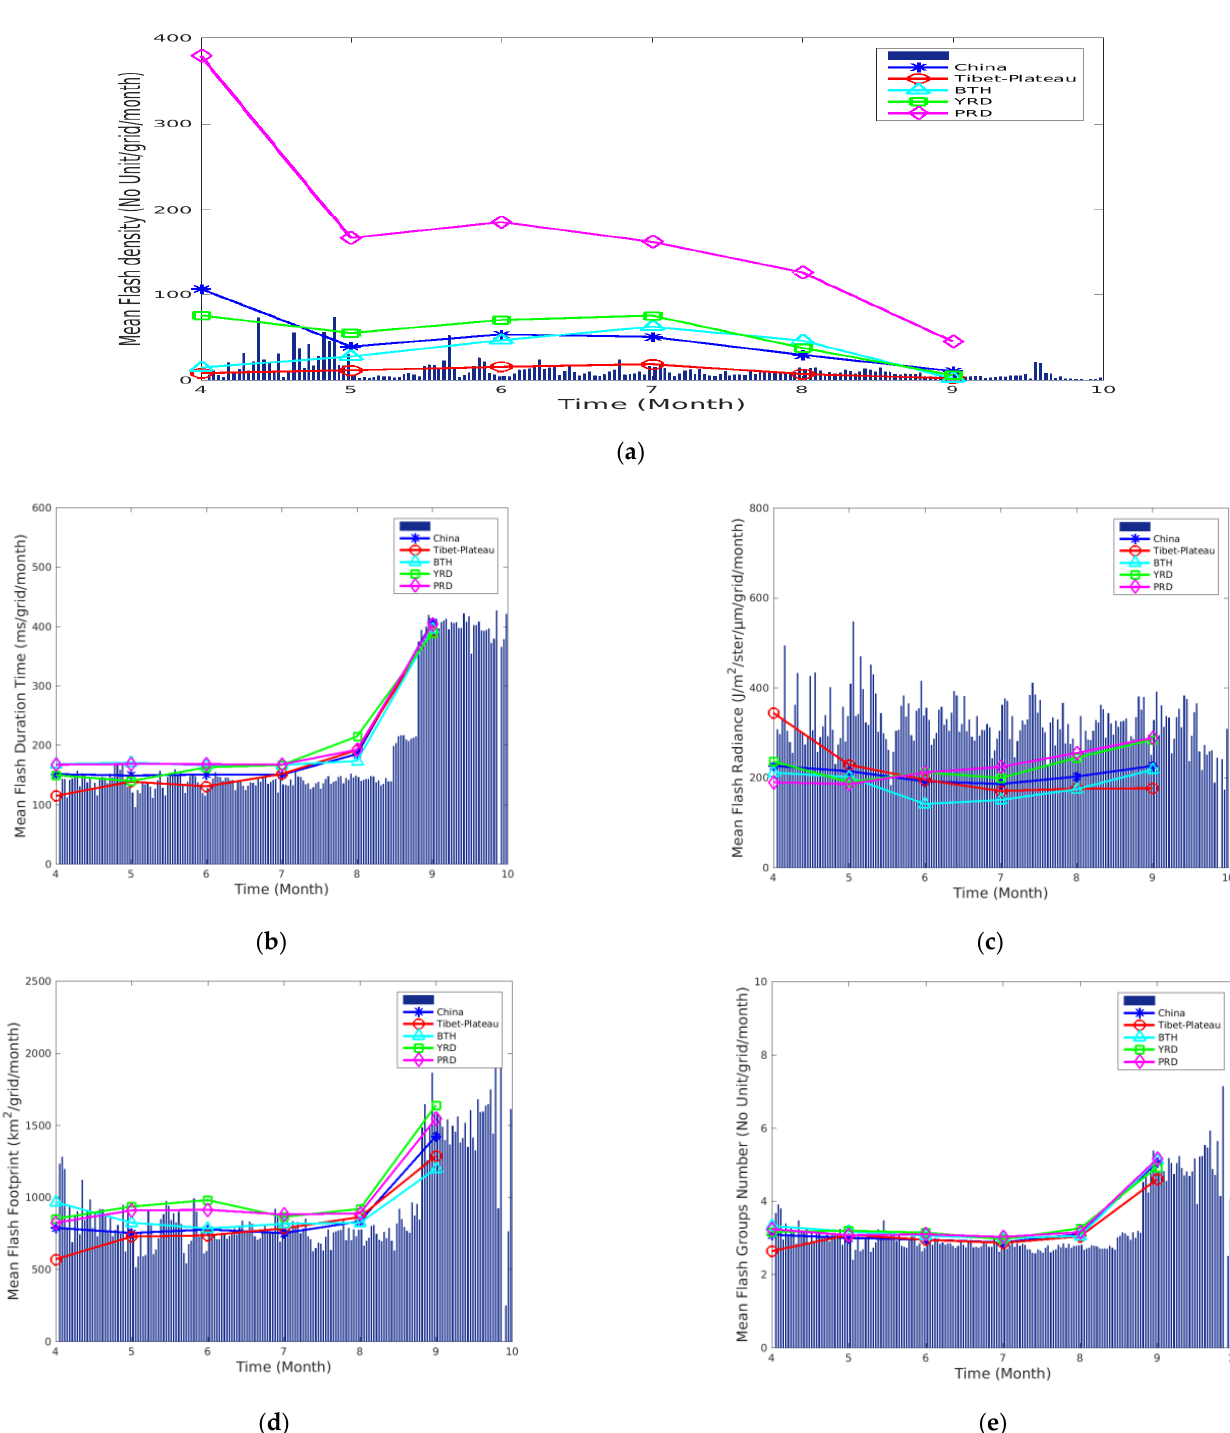
Figure 9. Temporal variation in the LMI Flashes in four typical regions in China. ( a ) Flash density, ( b ) Radiance, ( c ) Duration, ( d ) Footprint, and ( e ) Flash-Groups number. The bar chart indicates daily variation, and the line chart indicates monthly variation.